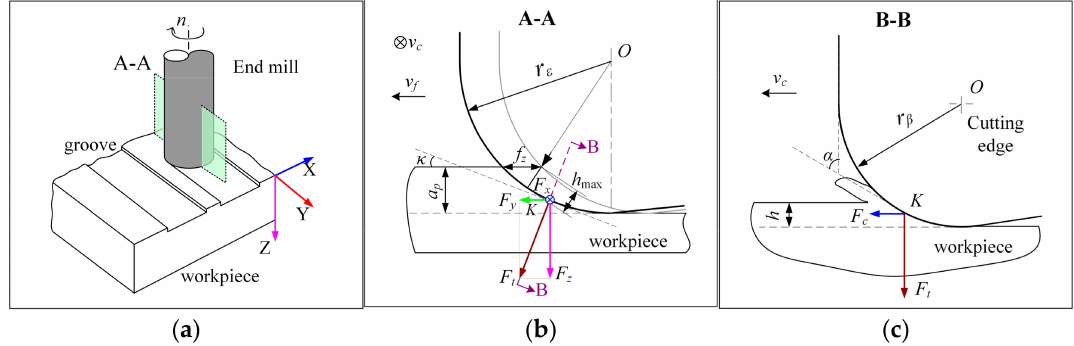
Figure 4. Schematic geometry in cutting zone, ( a ) sketch map of groove milling; ( b ) schematic geometry from A–A cross-section; ( c ) schematic geometry from B–B